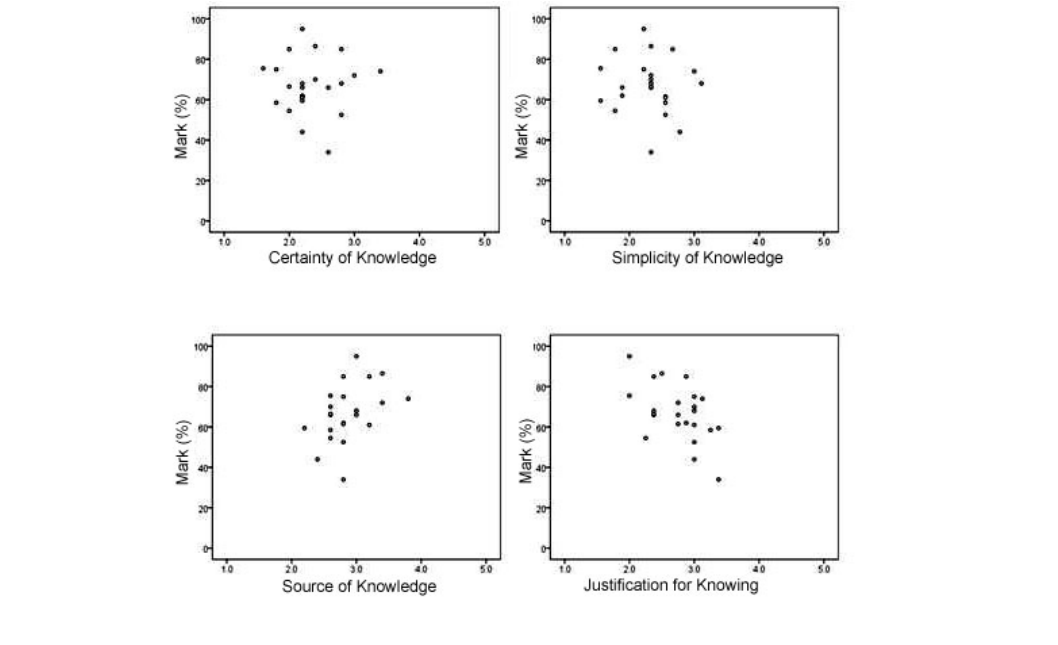
Fig. 2 . Relationship between scores for the four dimensions of PEBs of students and academic performance (expressed as a percentage) (n = 23). Low scores relate to more sophisticated